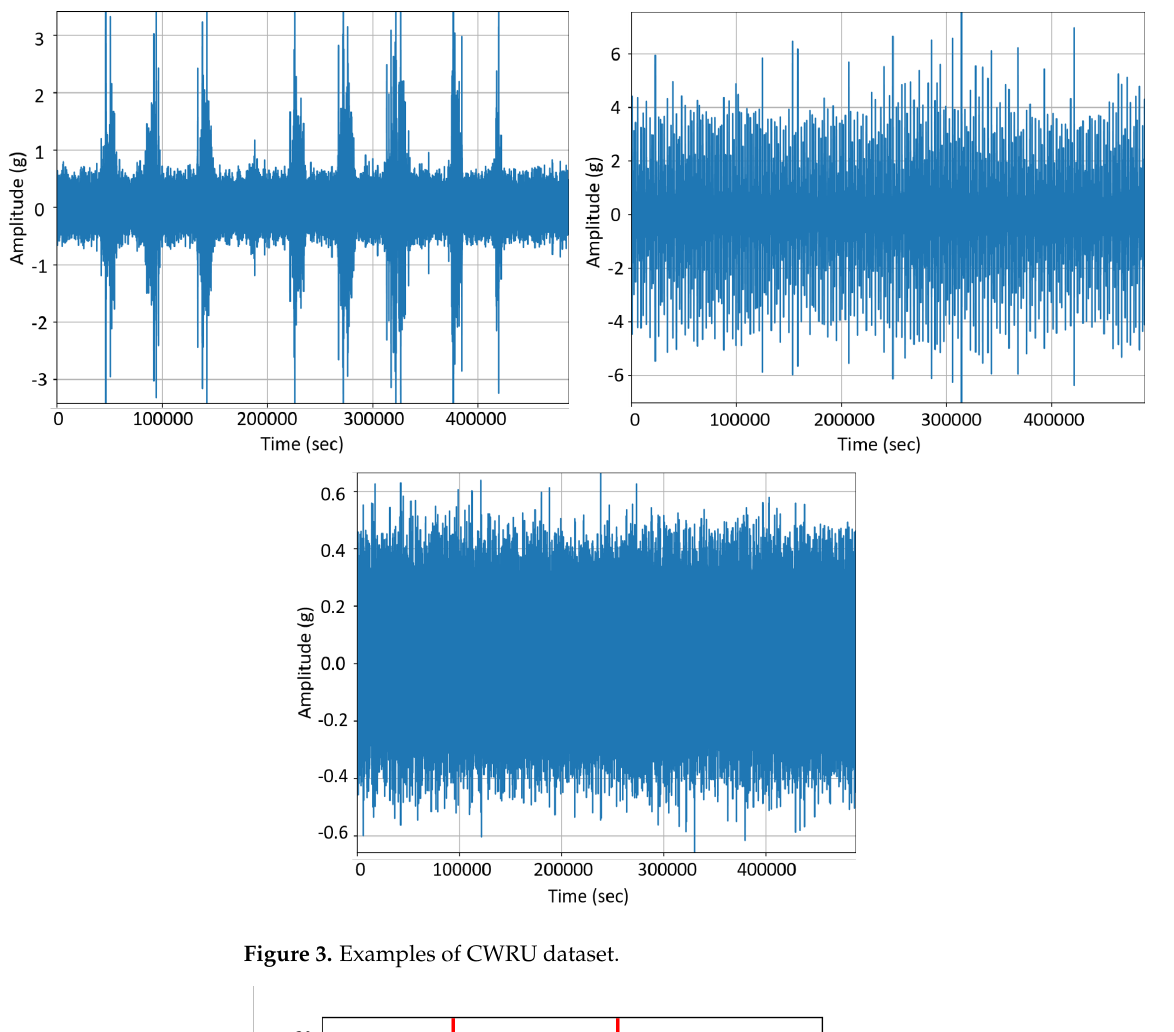
Figure 3. Examples of CWRU dataset.